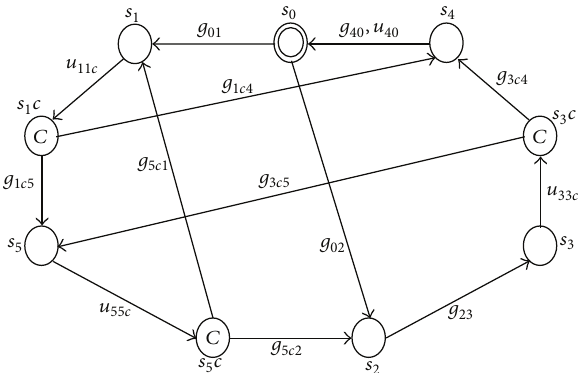
Figure 3: UPPAAL model of formal specification